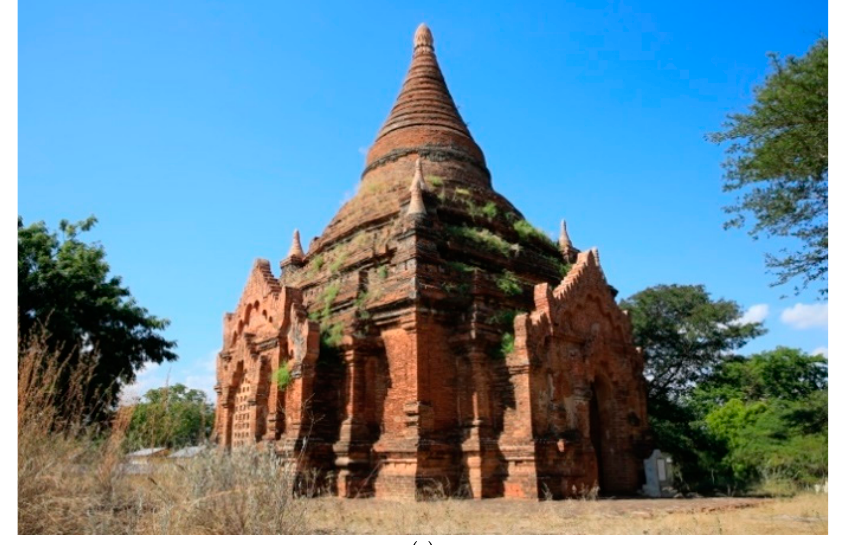
Figure 10. Pagan, Ananda Stupa, 11th Century, Jataka 422. Devadatta sinking into the earth, only the crowned head showing.